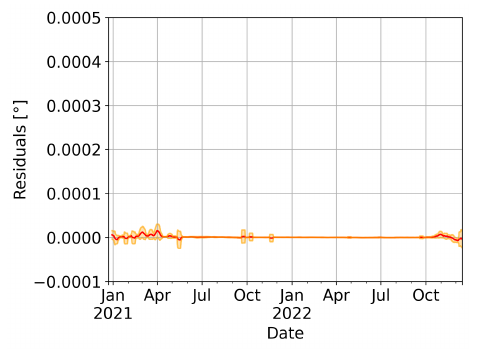
Figure 11. Autoencoder: T1